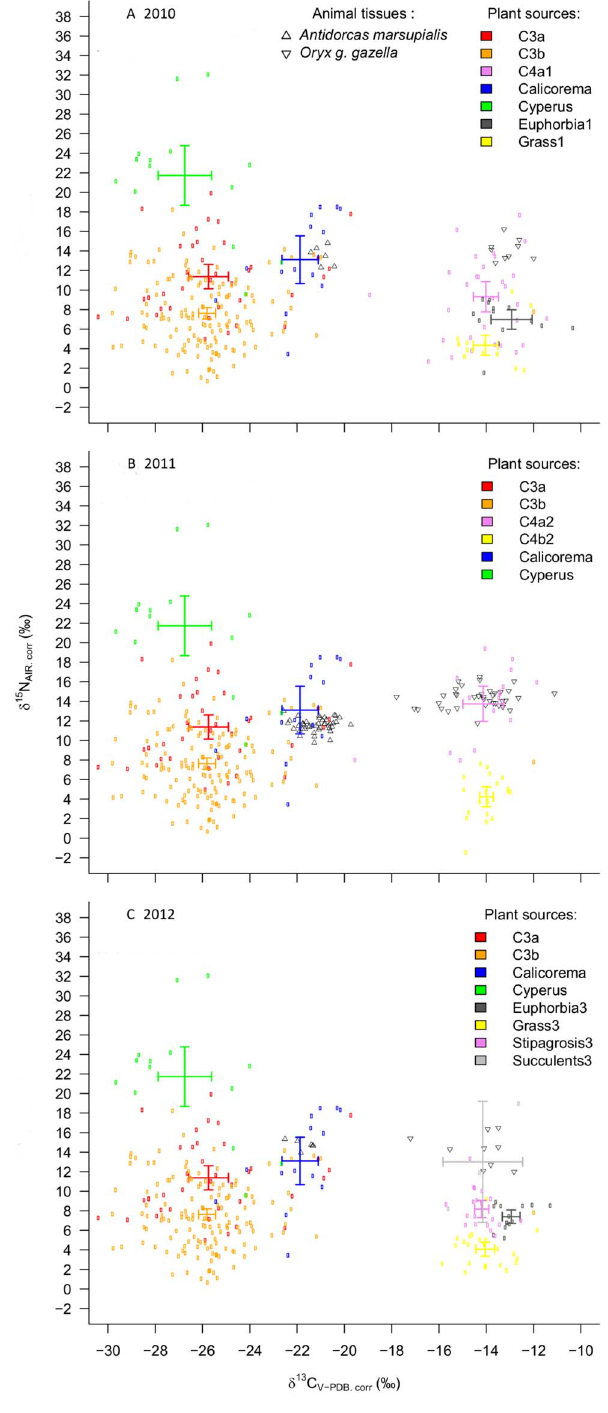
Figure 1. Isotopic projections along the nitrogen and carbon axes (all in delta notation) of the thirteen major potential food sources (Mean; 95%CI) in A) 2010, B) 2011 and C) 2012 plotted with the mean values of the three metabolically active tissues (blood, liver and muscle) of gemsbok and springbok sampled in A) 2010, B) 2011 and C) 2012.